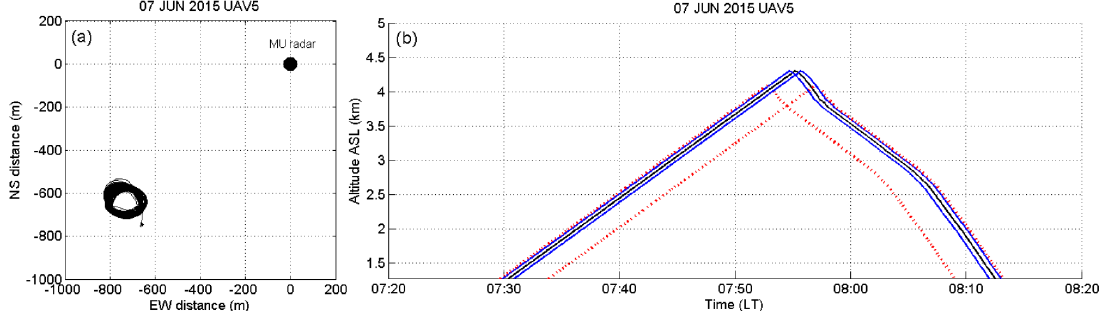
Figure 1. (a) Plot of GPS positions of UAV5 with respect to MU Radar antenna location. During ascent and descent, the UAVs were flying in a helical pattern of 100–150m diameter. The black dot indicates the position of the MU Radar antenna array. (b) Altitude above sea level (black; a.s.l.) vs. time plot of flight UAV5 launched at 07:14:11LT on 7 June 2015. The blue solid and red dotted lines show the two time intervals used for averaging the radar data at each altitude.